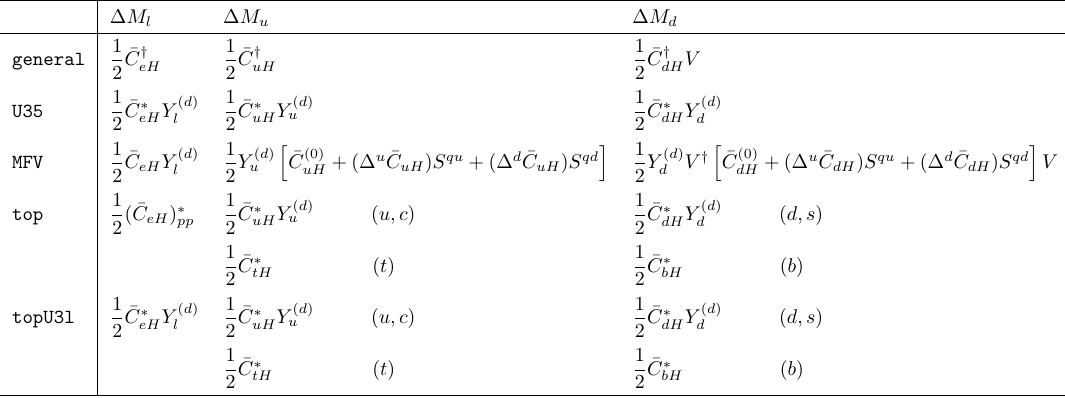
Table 5 . SMEFT corrections to the fermion mass matrices for each flavor assumption, see section 3 for all definitions. All Wilson coefficients are scalar quantities, except in the general case, where they are 3 × 3 matrices. In the MFV case all parameters are real. In the top and topU3l cases ∆ M are 2 × 2 matrices for the first two generations, and the mass term for the t, b quarks u,d , Y u,d are independent. We use the notation ¯ C = C (ˆ v 2 / Λ 2 ) and the results are given in the mass basis α α of the up-quarks and charged